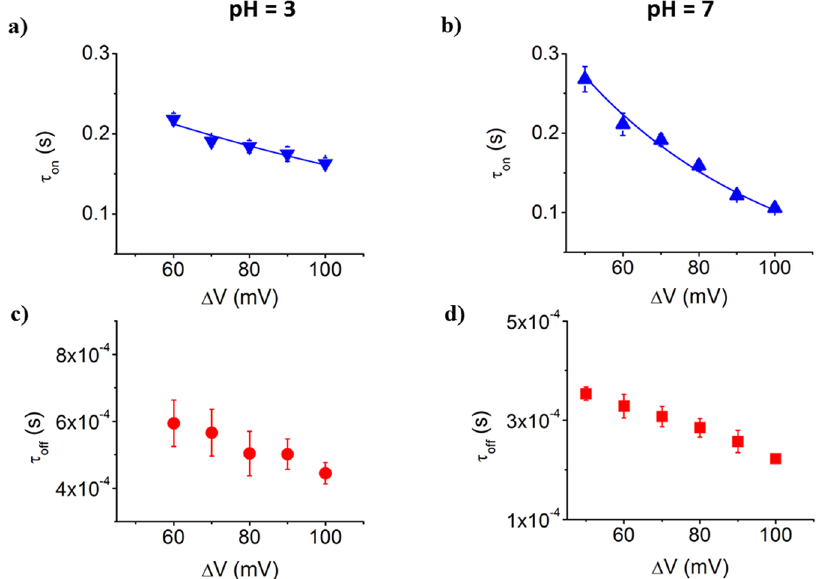
Figure 4. The dynamics of PAMAM-G1 – α -HL interactions, at acidic and neutral pH. The voltage-dependence of inter-event ( τ on ) and blockade duration intervals ( τ off ) characterizing the stochastic ionic current events associated to the dendrimer – α -HL interactions, at a 500 μ M concentration of the dendrimer in 1 M KCl, at pH = 3, panels a and c and pH = 7, panels b and d.